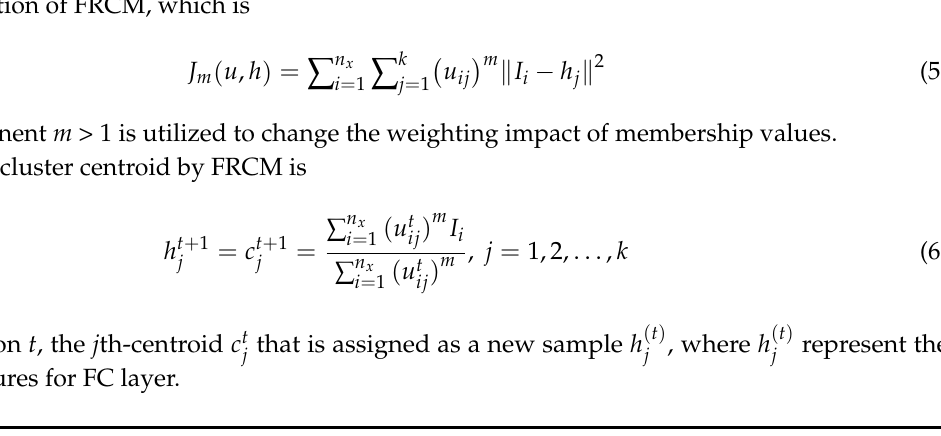
Algorithm 1 The Cluster Centroid